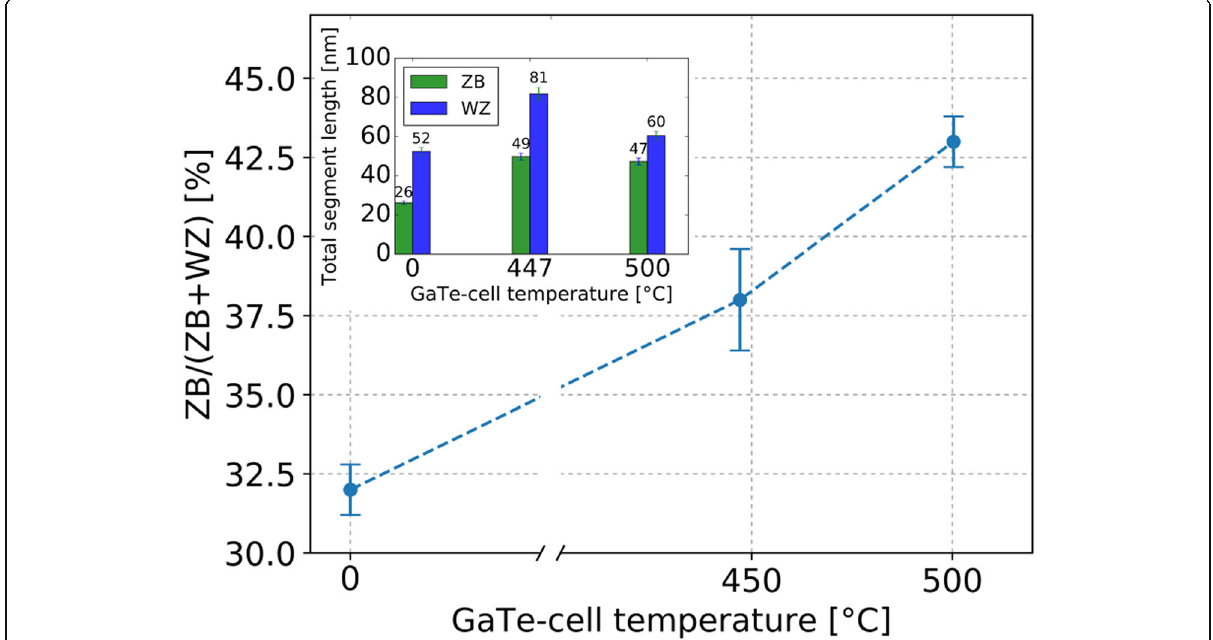
Fig. 4 Ratio between ZB and WZ segments. Ratio of the number of ZB segments and the total number of segments identified as WZ or ZB in dependence on the GaTe-cell temperature. For the first two measurements B1 and B3 have been analyzed. At 500 °C, the results of wires C1 and A4 were merged as they were grown at similar As-BEP. The bar plot in the inset depicts the accumulated length of all WZ and ZB segments present in the NW at the indicated cell temperature,